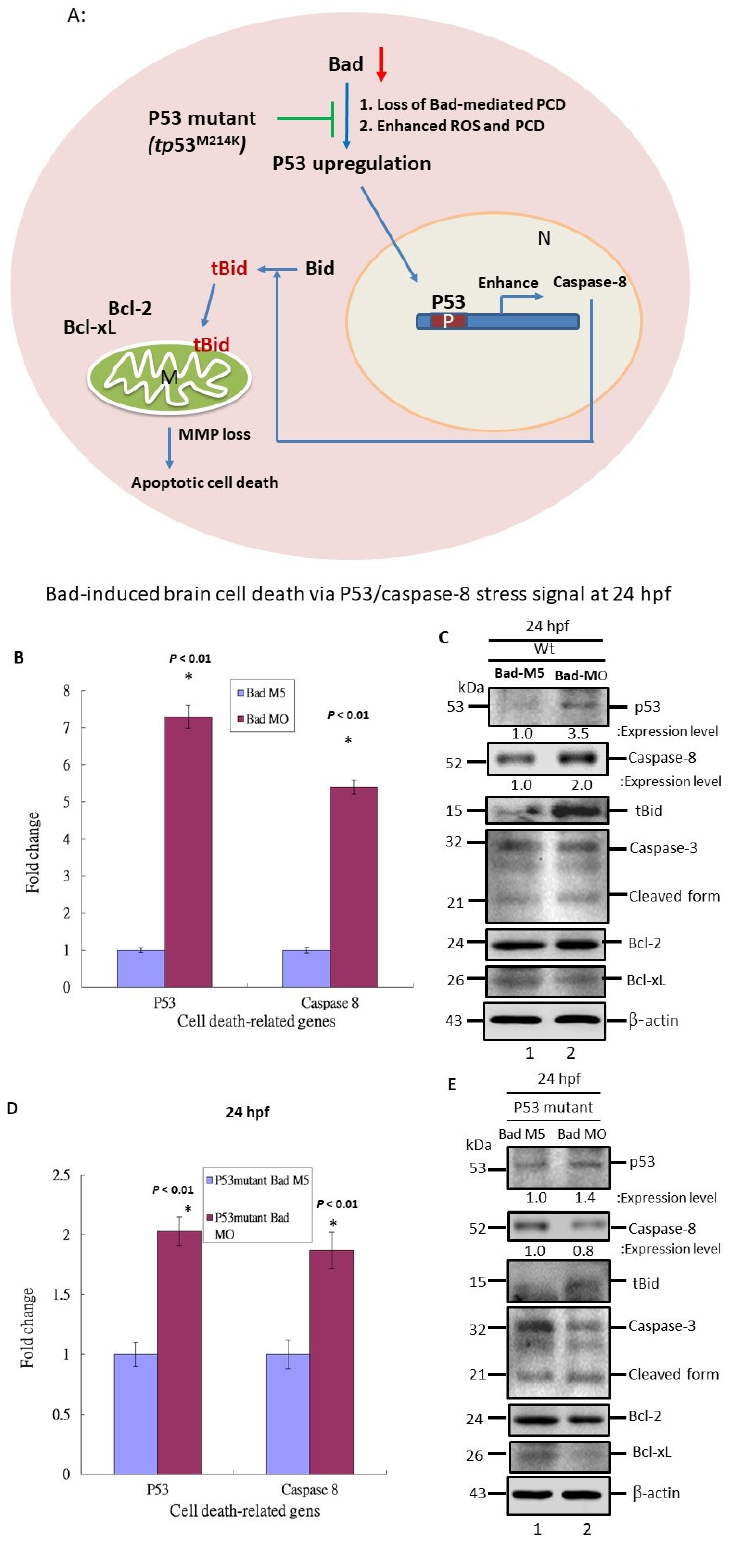
Figure 4. p53/caspase-8 death signaling involvement in Bad knockdown embryos at 24 hpf. ( A ) A network signaling death pathway was proposed based on accumulated data. The p53/caspase-8/tBid-mediated death pathway was induced. It also required upstream signaling from loss of Bad, leading to enhanced environmental stress with increased ROS and enhanced apoptotic cell death via the stress/death gene p53 and its correlated downstream gene expression caspase-8 or activation of tBid by cleavage from Bid. ( B ) Clear upregulation of p53 and caspase-8 demonstrated via qRT-PCR. All data were analyzed using either paired or unpaired Student’s t -tests, as appropriate. * p < 0.01. ( C ) Identification of apoptotic-related protein expression of p53/caspase-8/tBid as key molecules by Western blotting analysis at 24 hpf. Both p53 and caspase-8 showed stronger expression compared to the control group, correlated with downstream Bid cleavage and anti-apoptotic number Bcl-2 and Bcl-xL expression levels. ( D ) qRT-PCR evaluation of apoptosis-related gene expression with Bad knockdown in p53 mutant lines at 24 hpf. ( E ) Western blot analysis of apoptosis-related protein expression with Bad knockdown in p53 mutant fish lines correlated with downstream protein Bid cleavage and anti-apoptotic number Bcl-2 and Bcl-xL expression levels.